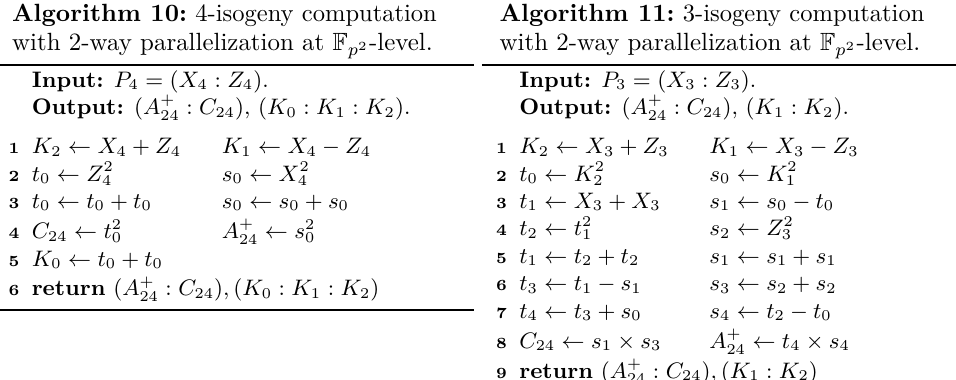
Algorithm 11: 3-isogeny computation -level. with 2-way parallelization at F p 2